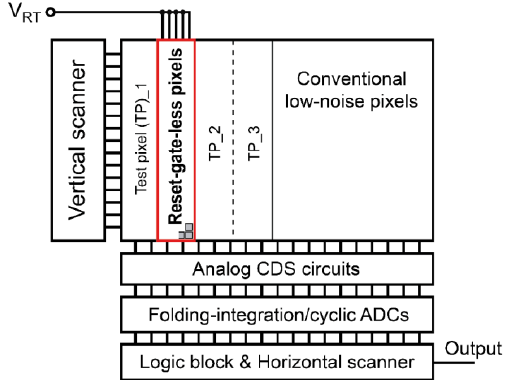
Figure 11. Block diagram of the experimental CIS chip.